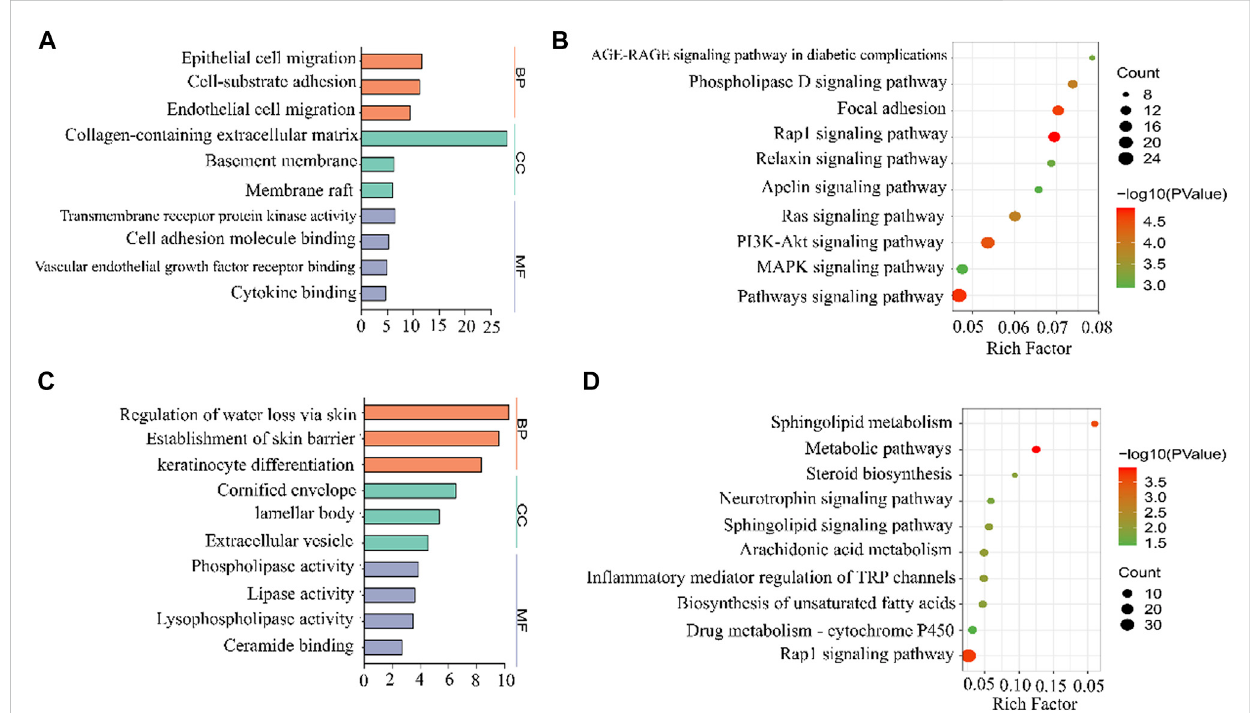
FIGURE 7 GO and KEGG analyses of DEGs among the control, IMQ, and LYS-High groups. GO enrichment analysis predicted the functional roles of targethostgenesbased onthecontrol,IMQ, and LYS-Highgroups. (A) ExpressionofDEGsdecreasedwithIMQ treatmentandthen increasedwith LYS treatment. (B) Expression of DEGs increased with IMQ treatment and then decreased with LYS treatment. The top-three terms of BP, CC, and MF analyses are represented by three different colors in this fi gure: Orange, BP; green, CC; purple, MF. (C) KEGG enrichment analysis based on DEGs whose expression decreased with IMQ treatment and then increased with LYS treatment. (D) KEGG enrichment analysis based on DEGs whose expression increased with IMQ treatment and then decreased with LYS